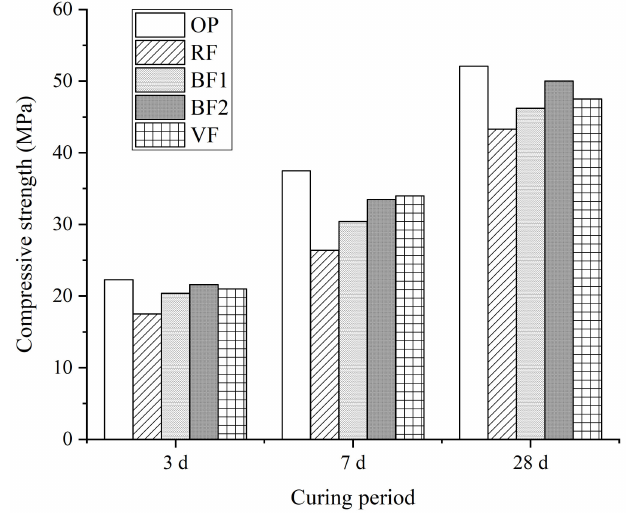
Figure 8. Compressive strength of cement mortar containing ground fly ash.